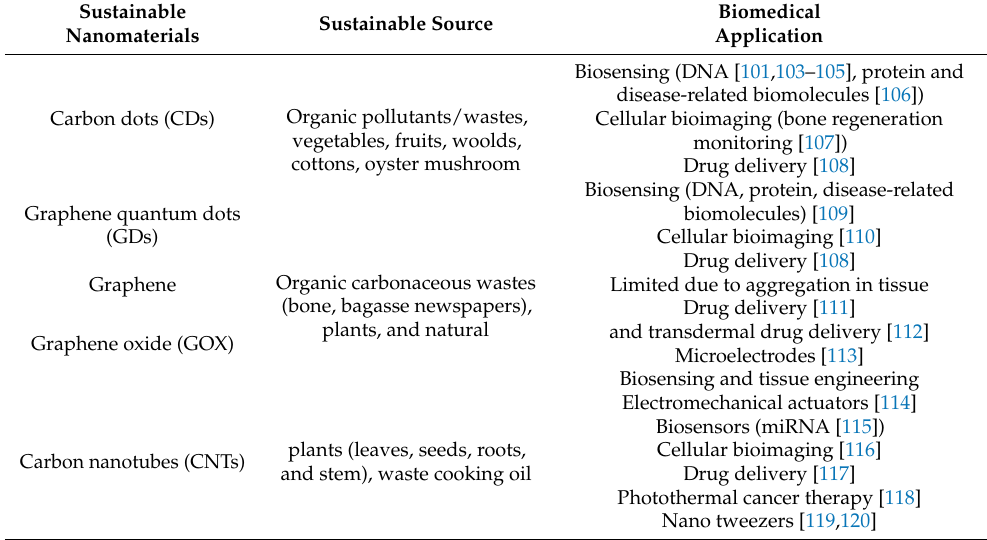
Table 3. Summary of carbonaceous material for biomedical